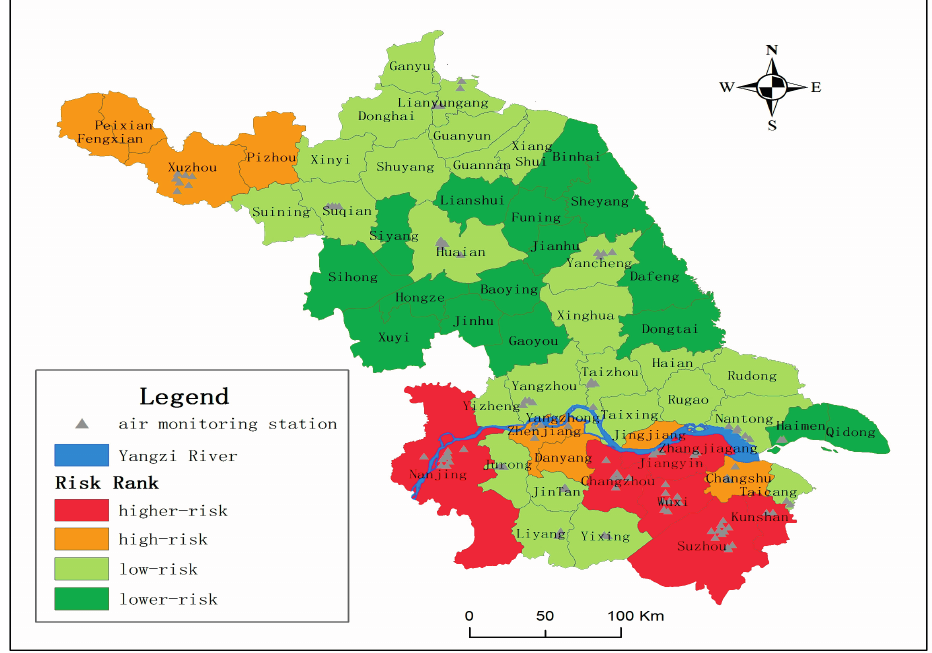
Figure 1. Comprehensive risk distribution of environment and health in the Jiangsu